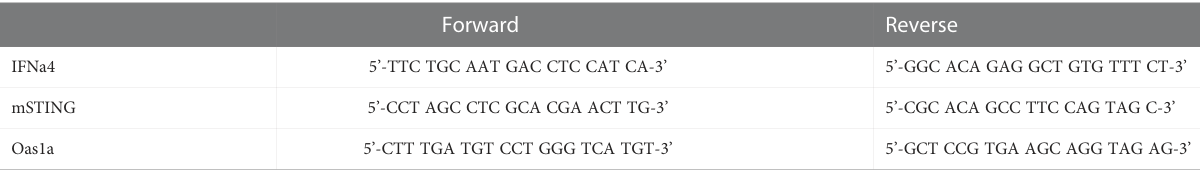
TABLE 1 Oligonucleotide primer pairs for targeted genes of